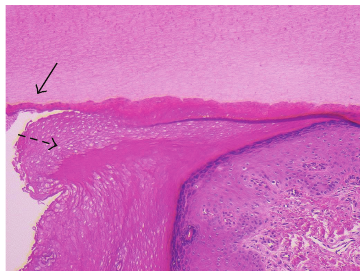
Figure 3: A biopsy specimen from the left second finger showed (i) a marked, highly eosinophilic, keratinized substance attaching the distal and visceral nail plate (arrow) and (ii) a whorled, highly eosinophilic, keratinized substance into the horny layer of the finger tip (dotted arrow) (Hematoxylin and eosin staining, original magnification × 100).